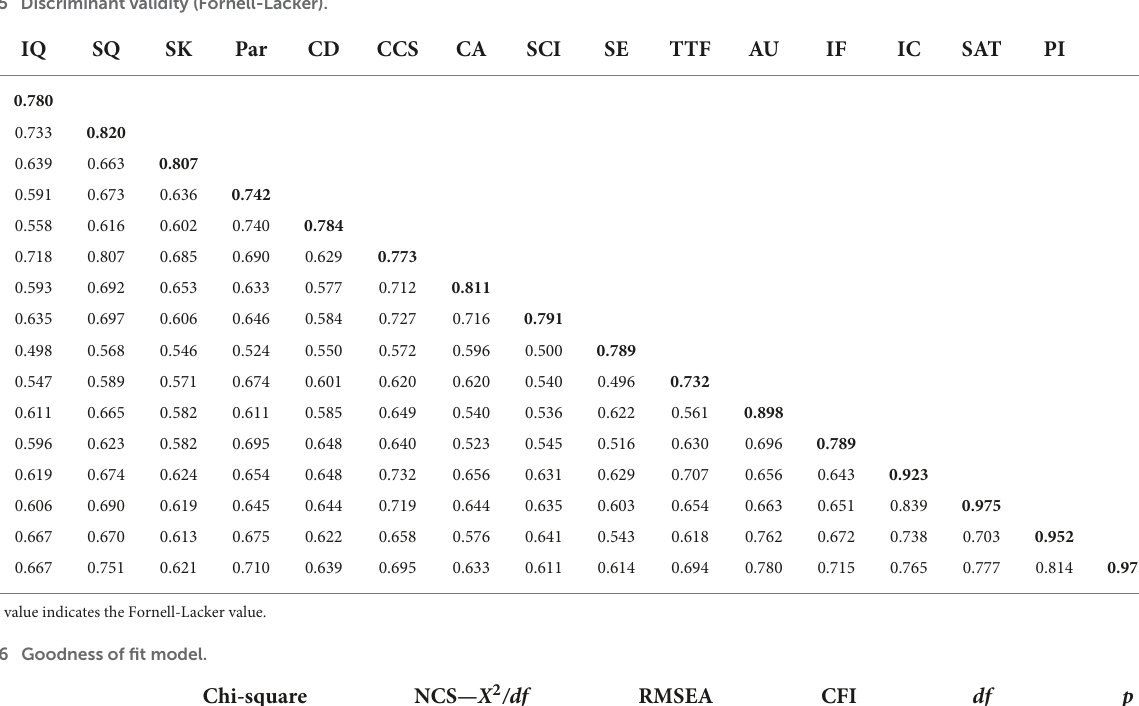
TABLE 5 Discriminant validity (Fornell-Lacker).